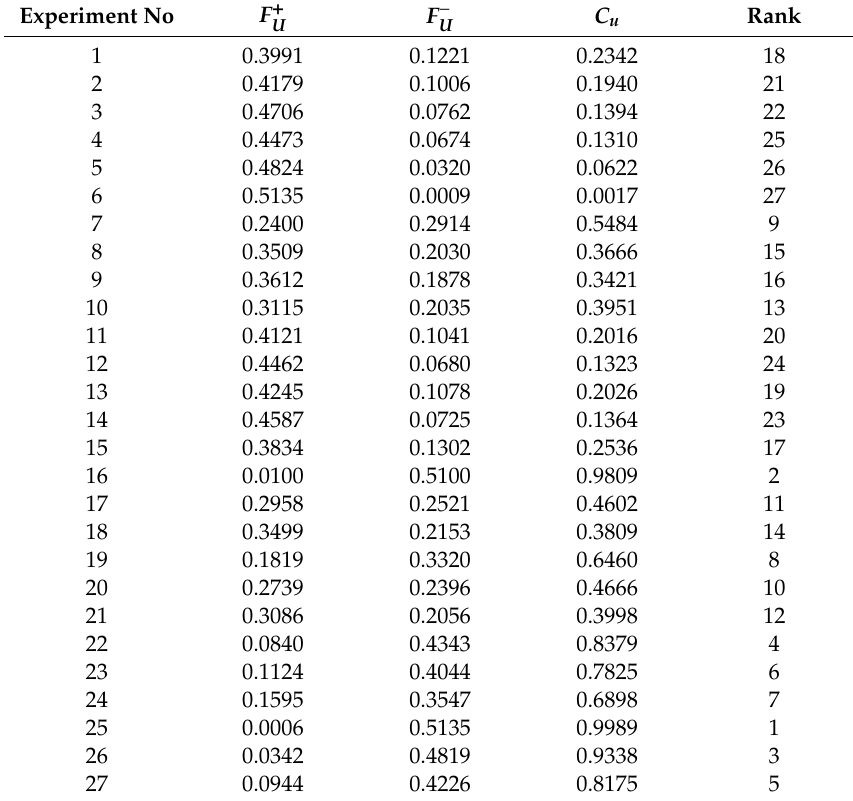
Table 7. Nearness coe ffi cient values and alternative ranking.